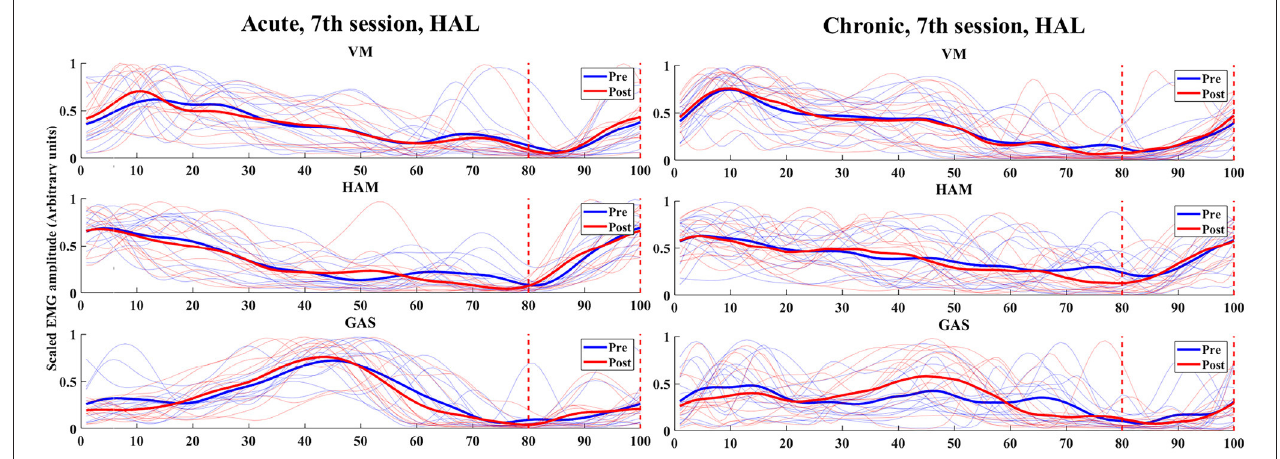
FIGURE 6 | EMG (VM, HAM, and GAS) of acute and chronic stage patients, pre and post 7th HAL session.